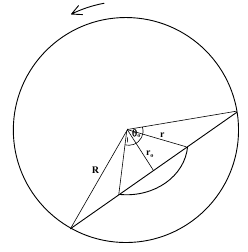
Fig. 2 Geometric arrangement used in the analysis of convective mixing Figure 2. Geometric arrangement used in the analysis of convective mixing in the in the transverse plane of a rotating cylinder. transverse plane of a rotating